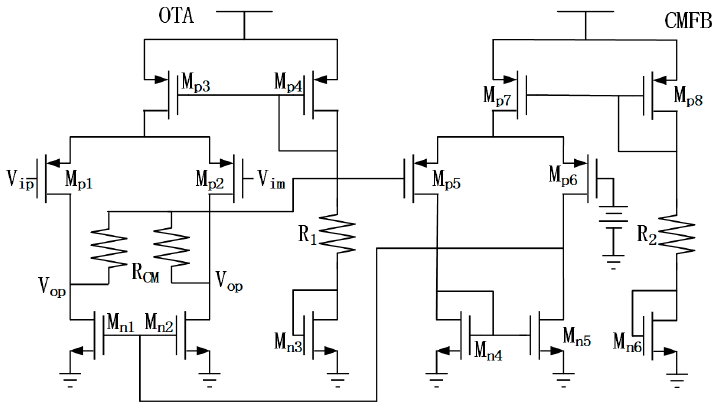
Figure 14. Schematic of the OTA (operational transconductance amplifier) and CMFB (common-mode